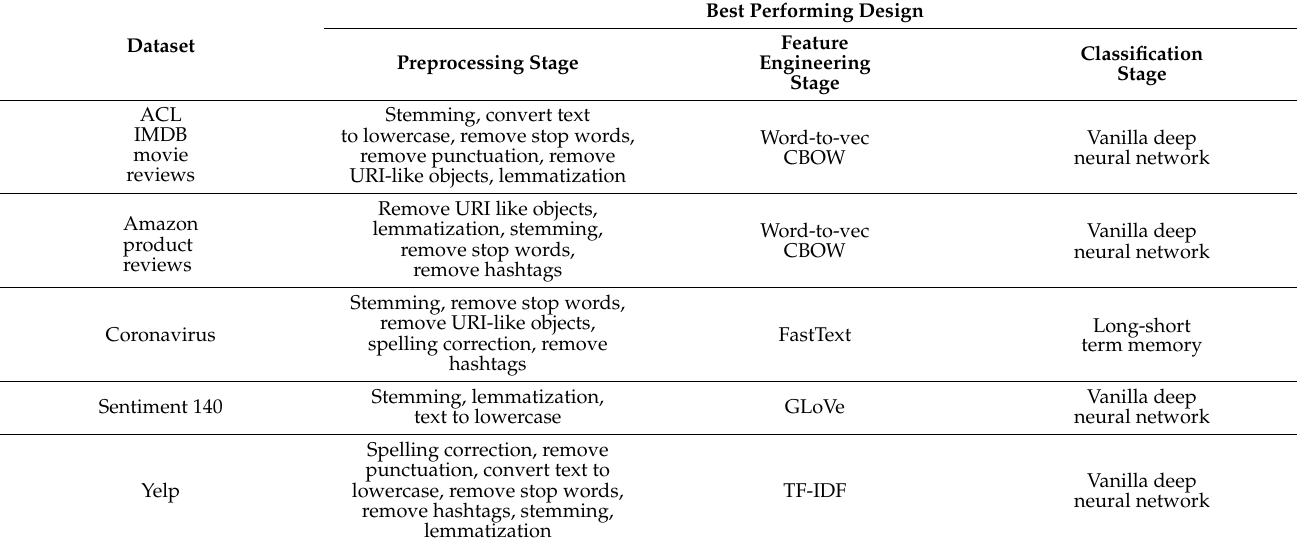
Table 16. Best-performing designs produced by the SPHH for the sentiment analysis datasets.